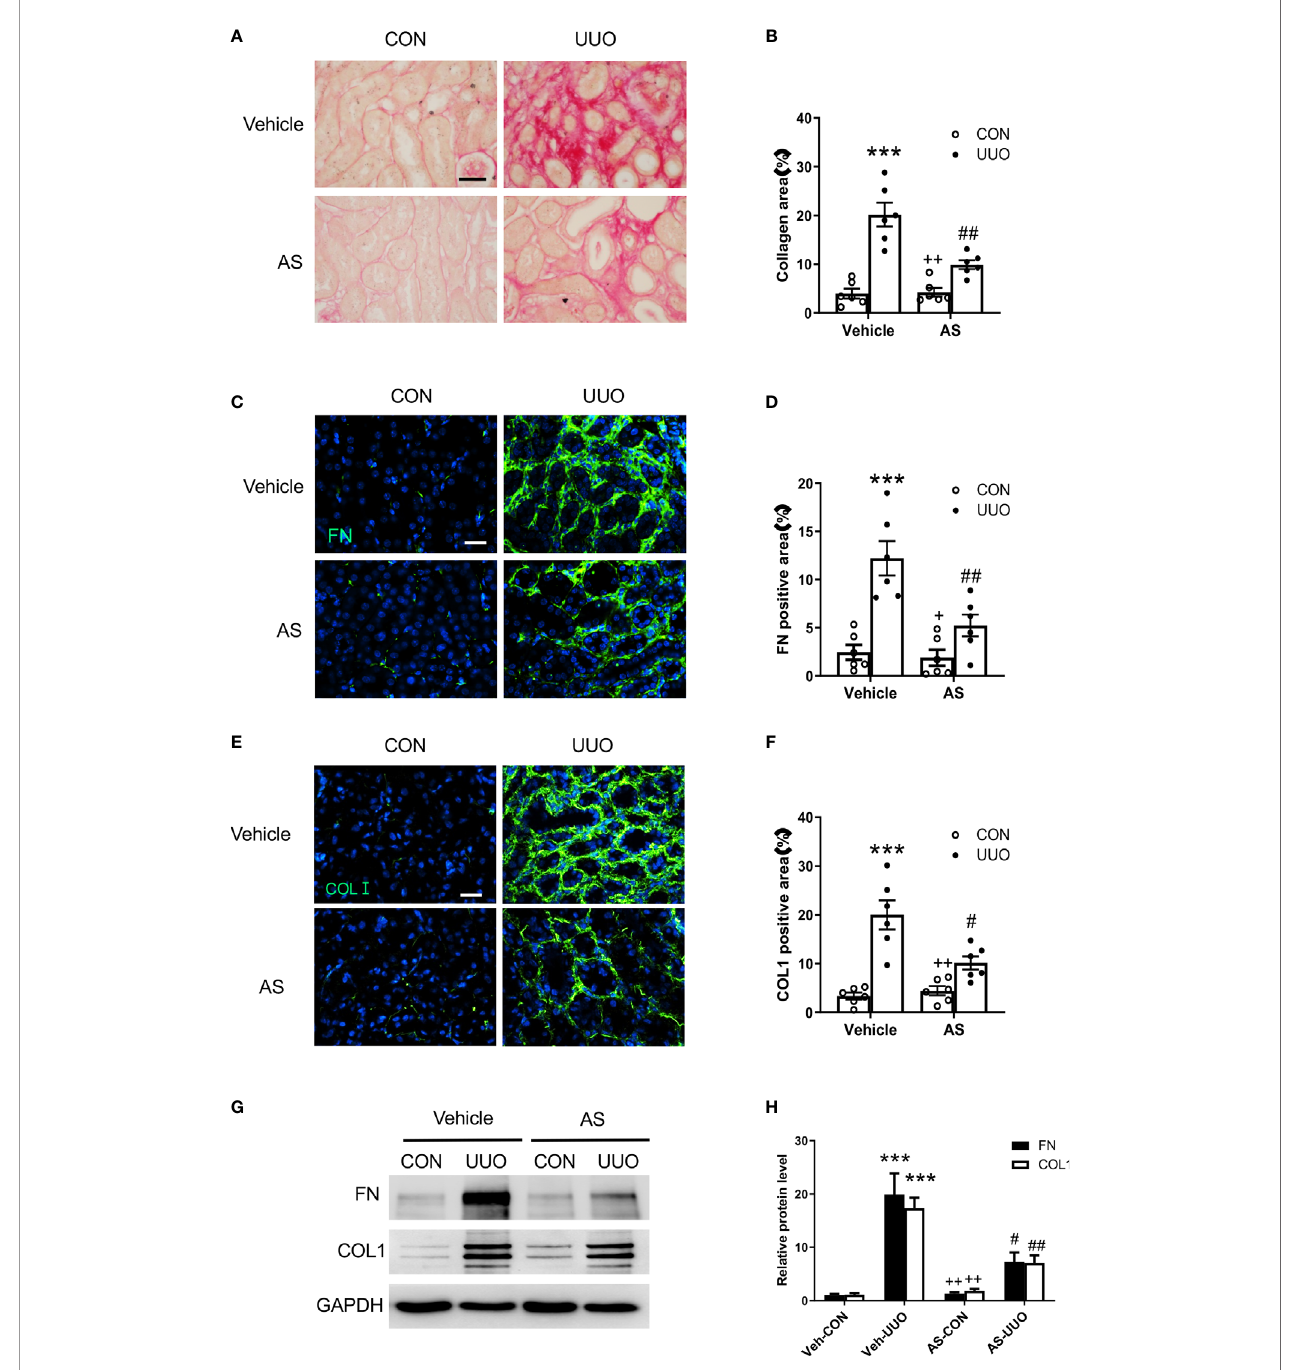
FIGURE 4 | AS1517499 attenuates renal fi brosis and ECM protein production in the kidney with obstructive injury. (A) Representative photomicrographs of kidney sections stained with Sirius red for evaluation of total collagen deposition in the kidney. Scale bar, 50 m m. (B) Quantitative analysis of interstitial collagen deposition in the kidney. *** P < 0.001 vs Vehicle-CON. ## P < 0.01 vs Vehicle-UUO, ++ P < 0.01 vs AS-UUO. n = 6 per group. (C) Representative photomicrographs of the kidney sections stained for fi bronectin (green) and counterstained with DAPI (blue). Scale bar, 50 m m. (D) Quantitative analysis of fi bronectin-positive area in the kidney. *** P < 0.001 vs Vehicle-CON. ## P < 0.01 vs Vehicle-UUO, + P < 0.05 vs AS-UUO. n = 6 per group. (E) Representative photomicrographs of the kidney sections stained for collagen I (green) and counterstained with DAPI (blue). Scale bar, 50 m m. (F) Quantitative analysis of collagen I positive area in the kidney. *** P < 0.001 vs Vehicle-CON. # P < 0.05 vs Vehicle-UUO, ++ P < 0.01 vs AS-UUO. n = 6 per group. (G) Representative Western blots show protein expression of fi bronectin and collagen I in the kidney. (H) Quantitative analysis of protein levels of fi bronectin and collagen I in the kidney. *** P < 0.001 vs Veh-CON; ## P < 0.01, # P < 0.05 vs Veh- UUO; ++ P < 0.01 vs AS-UUO. n = 6 per